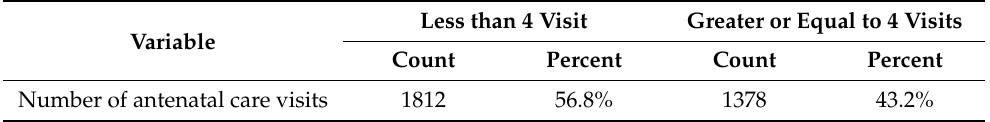
Table 1. Descriptive result of outcome variables.